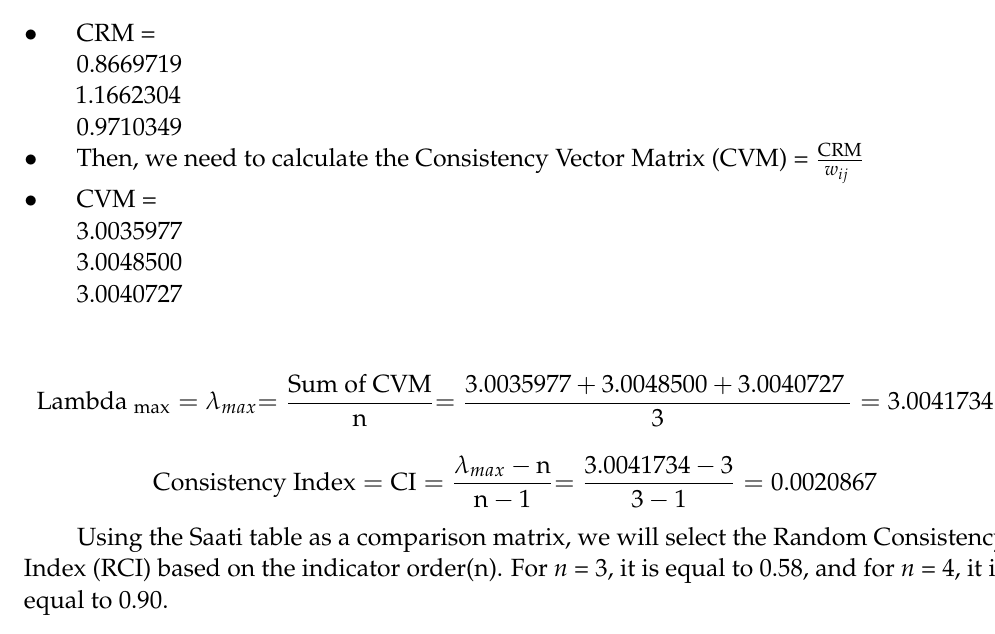
Using the Saati table as a comparison matrix, we will select the Random Consistency Index (RCI) based on the indicator order(n). For n = 3, it is equal to 0.58, and for n = 4, it is equal to